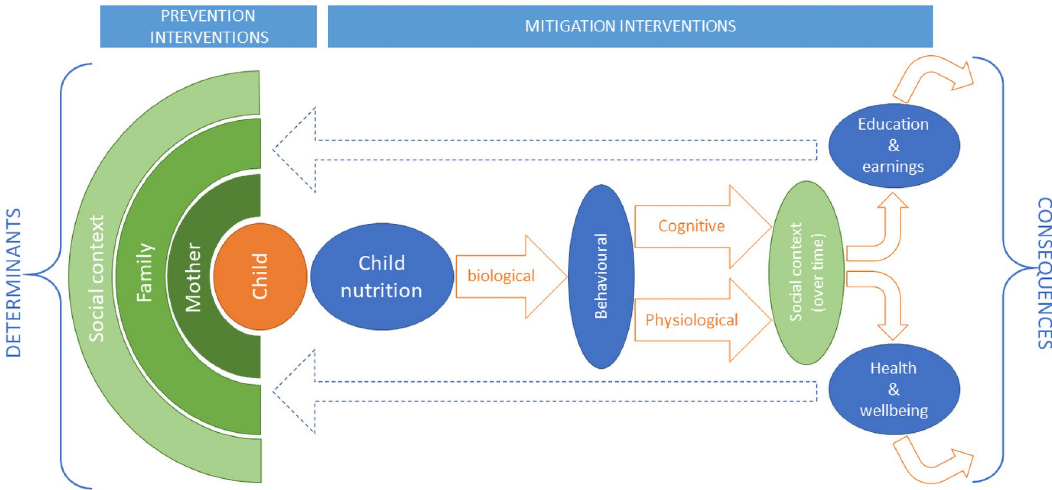
Fig 1. The determinants and consequences of nutritional status in the first 1000 days plus. The immediate and short-term biological consequences of unmitigated poor early nutrition include impacts on cognitive development and physiological health, including mortality, with some variation associated with child level differences, such as genetics [6,8,9].The long-term implications of these consequences are largely dependent on whether, and how quickly, children access appropriate interventions [10,11]. Without intervention, the cognitive consequences of poor nutritional status can make school more difficult, often leading to early drop-out, and consequent lower earnings [12]. Positive caregiver responses such as accessing appropriate services, and providing adequate child stimulation can compensate for nutritional deficits, thus limiting negative biological consequences of poor early nutrition [13,14].Conversely, caregivers attempting to protect a child they perceive as weak because of their nutritional status may inadvertently worsen biological outcomes through under-stimulation [15–17].Early interventions have the greatest potential to reverse the consequences of early malnutrition, but many later-life interventions, such as quality schooling, can mitigate the effects of early malnutrition on health, education and associated earnings, and wellbeing [18–20]. The later life outcomes of adults who experienced poor early nutrition are shaped by their socio-economic context, such as the labour market. These later life outcomes shape the family circumstances of the next generation of children. This leads to intergenerational consequences of poor early nutrition